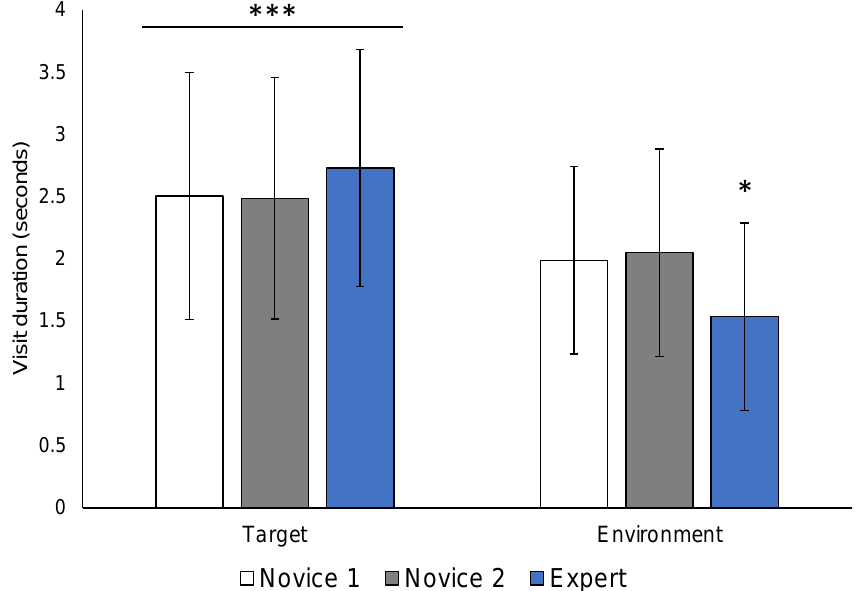
Figure 3. Average visit duration for target versus environment areas of interest. The mean time (in seconds) spent fixating on or scanning pre-defined target (left bars) and environment areas of interest (right bars) for 7 images are presented for each group (shown in different colours). All groups spent significantly more time fixating and scanning target areas compared to the environment. Experts spent significantly less time viewing the environment compared to both novice groups. *** p < 0.001, * p < 0.05.